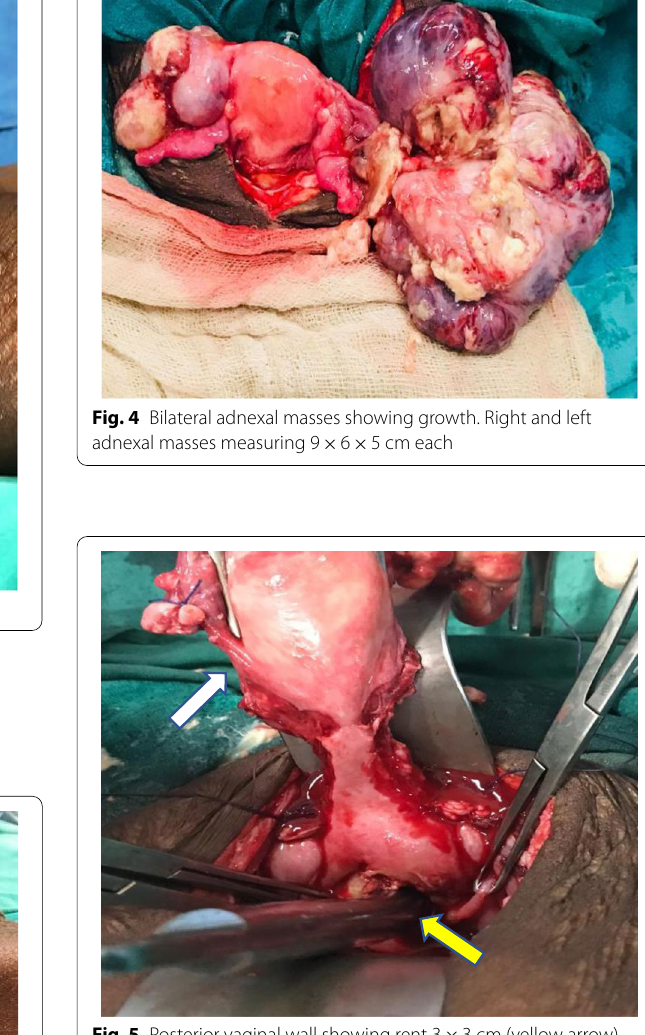
Fig. 5 Posterior vaginal wall showing rent 3 and uterus (white